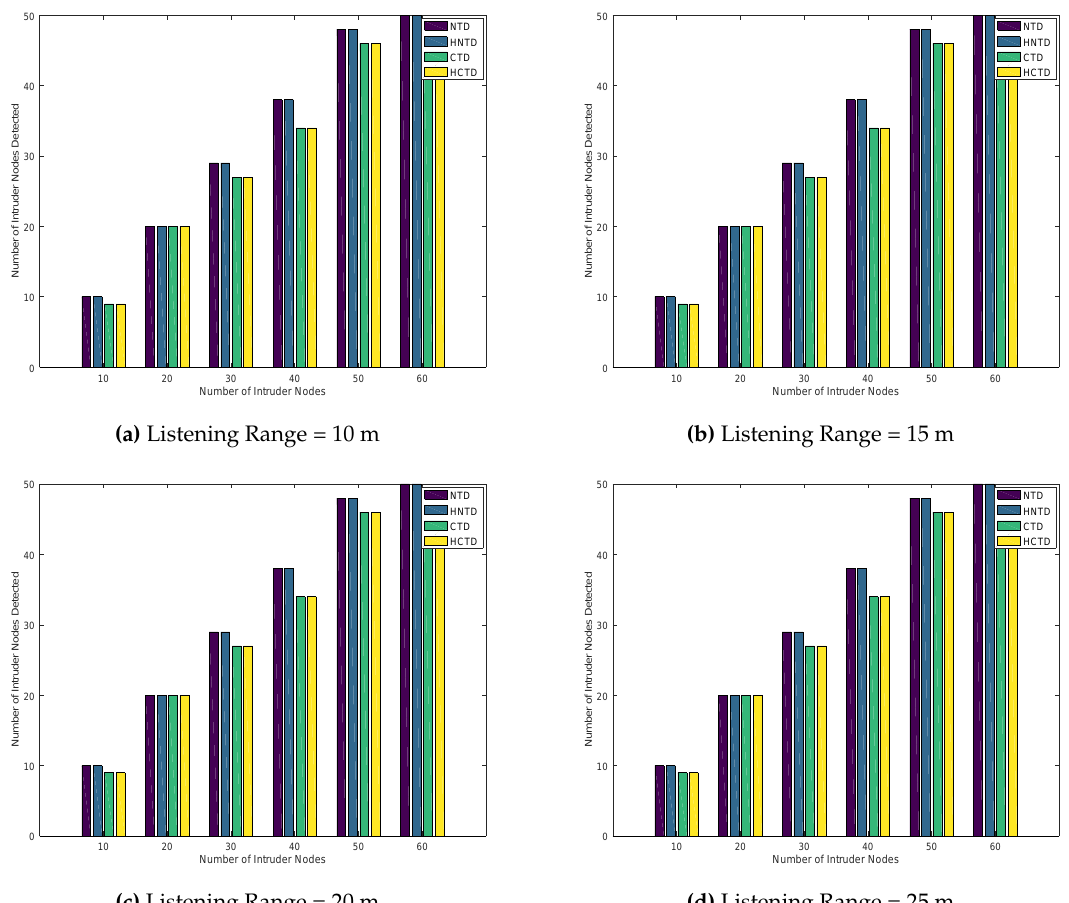
Figure 11. Number of Intruder Nodes Detected for Randomly placed